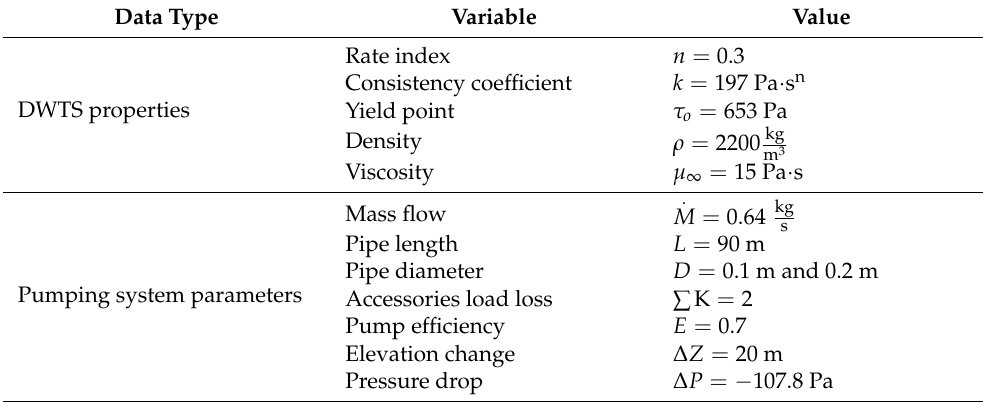
Table 6. Data for example problem .